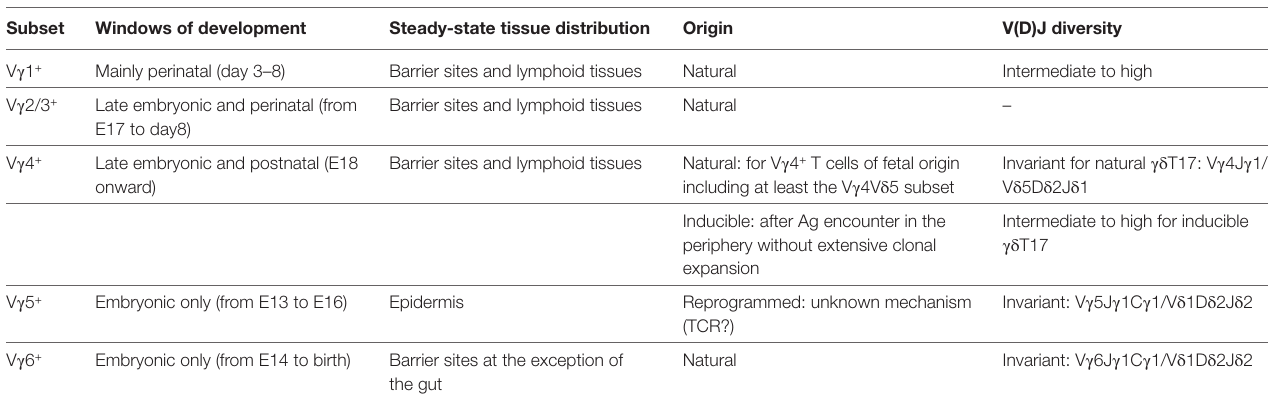
TAble 1 | Origin, tissue distribution, and TCR repertoire of γδ T17